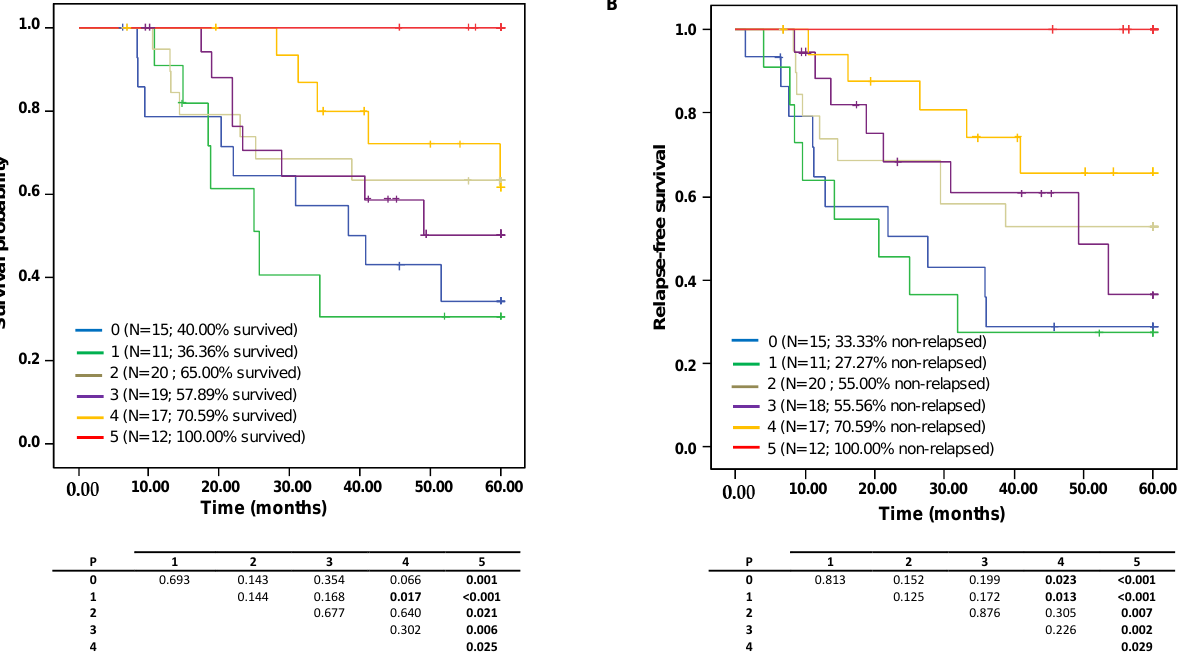
Figure 3. Kaplan–Meyer analysis of five-year survival probability with respect to the effect of the combinations having elevated content of 0 to 5 of the selected immune markers (CD4, FOXP3, CD1a, CD21, CD83) on ( A ) overall survival (OS) and ( B ) relapse-free survival (RFS) probabilities.